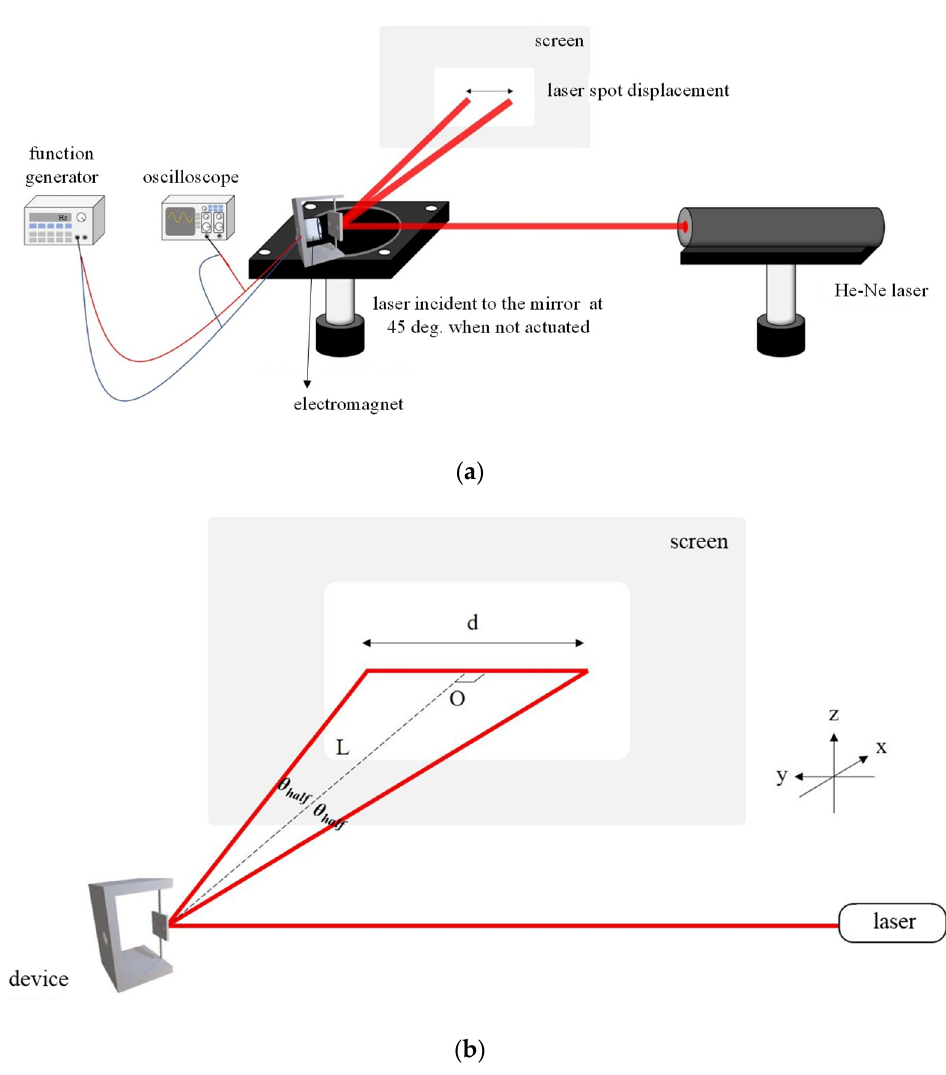
Figure 5. Dynamic characterization: ( a ) experimental setup; ( b ) the full optical scan range [ θ full = 2 θ half = 2tan − 1 (d/2L)] at a certain voltage amplitude and frequency can be found using the given L and measured d; the frequency response can be obtained by sweeping the frequency of the function generator.